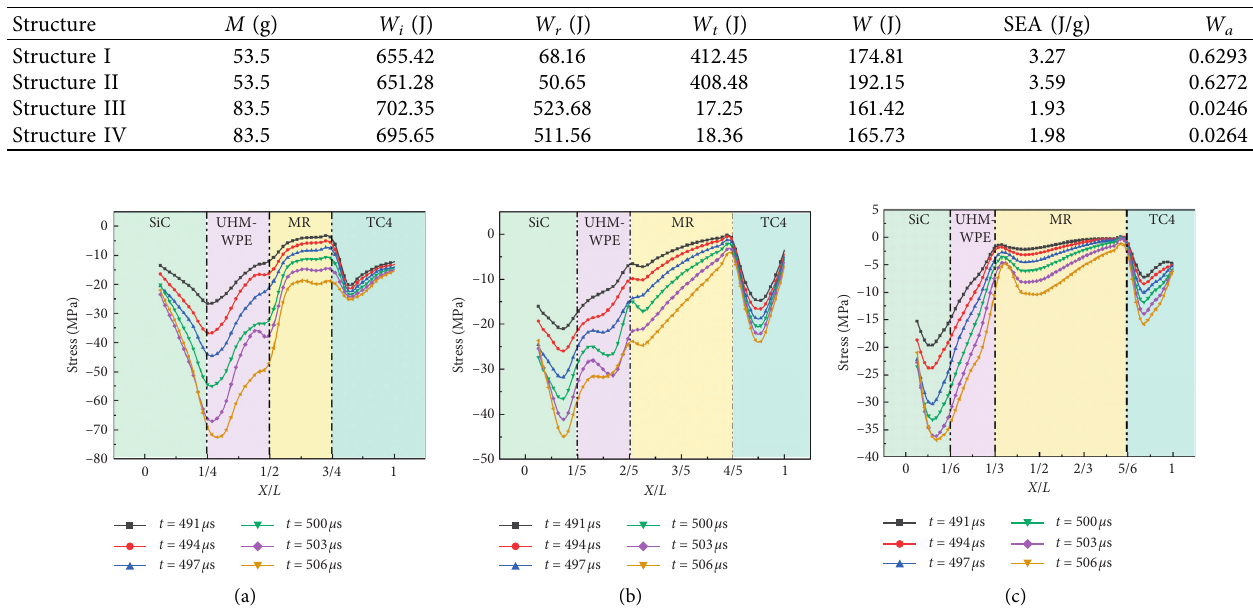
Figure 10: Structure III with different MR thicknesses: (a) 5mm MR; (b) 10mm MR; (c) 15mm